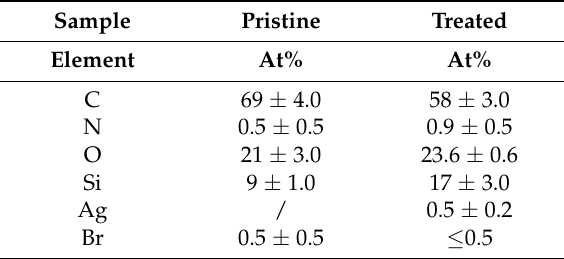
Table 1. Surface elemental composition estimated by X-ray photoelectron spectroscopy (XPS) of leather samples treated with 4% w / w Ag precursor. Error is expressed as the larger value between the error associated to a single quantification (0.2% for silver, 0.5% for other elements) and one standard deviation, calculated on at least three replicate analyses. Data on pristine samples are reported for comparison.